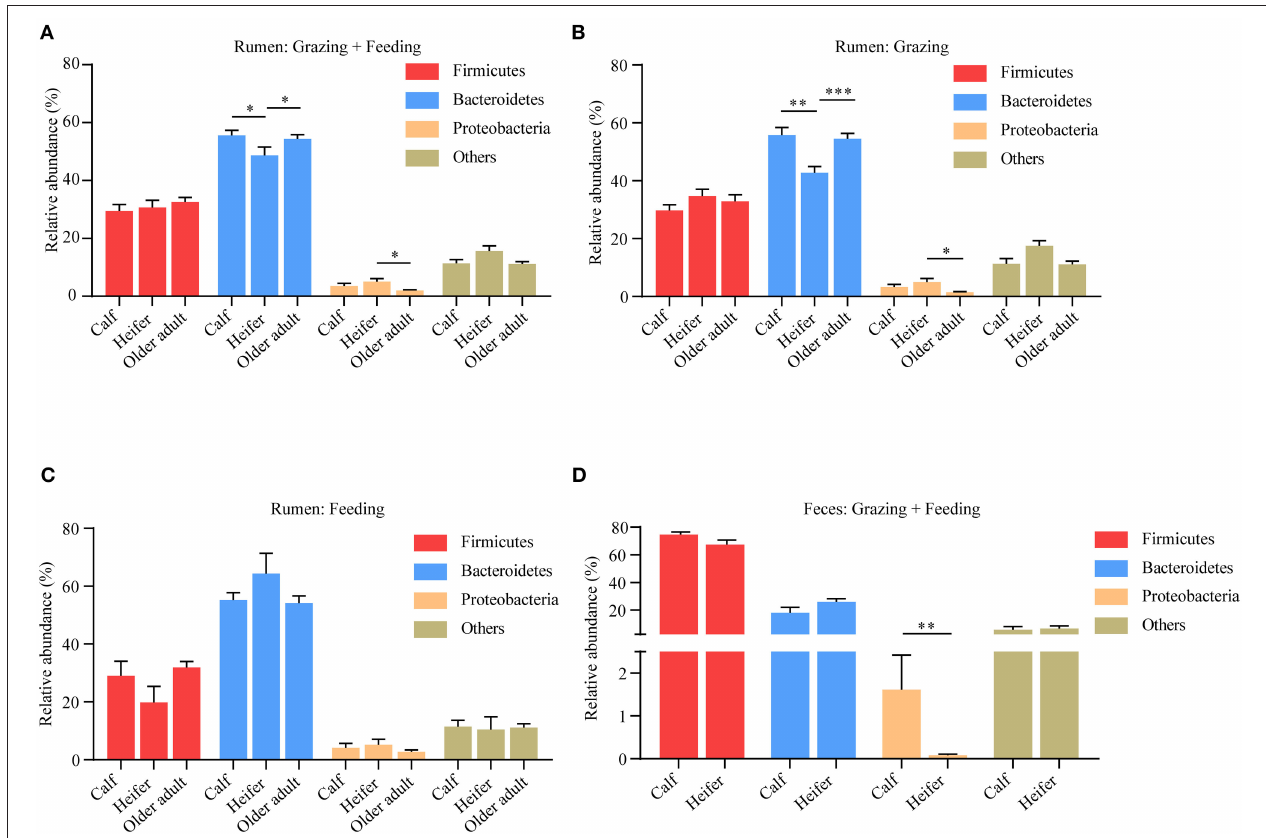
FIGURE 5 | Influence of age on yak rumen and fecal microbiota. (A) The relative abundance at the phylum level of rumen microbiota was compared between age groups, irrespective of the method of yak husbandry. The difference of each phylum across different age groups when yak kept grazing (B) and indoor (C) . The data were expressed as mean ± SEM. The Kruskal–Wallis test with post hoc Dunn’s test was used for multiple comparisons. * p < 0.05, ** p < 0.01, *** p < 0.001. (D) Influence of age on yak fecal microbiota. The relative abundance at the phylum level was compared between age groups, irrespective of the method of yak husbandry. The data were expressed as mean ± SEM. The Mann–Whitney test was applied for availability of data. ** p <